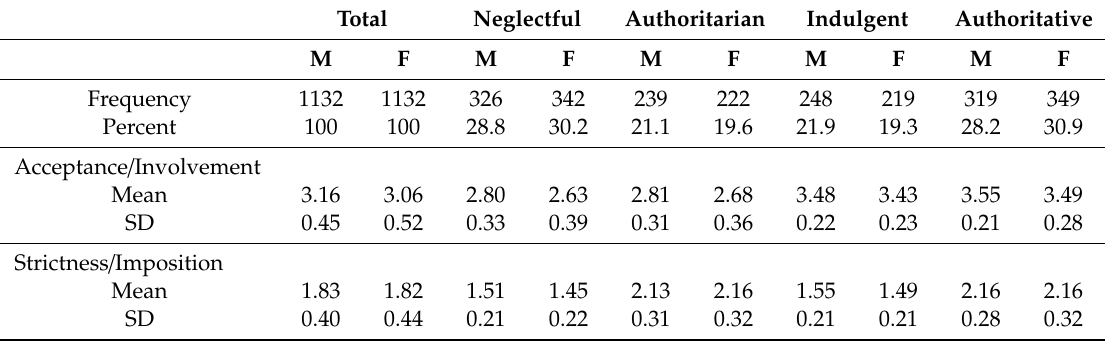
Table 2. Means in the four categories and gender ( N =